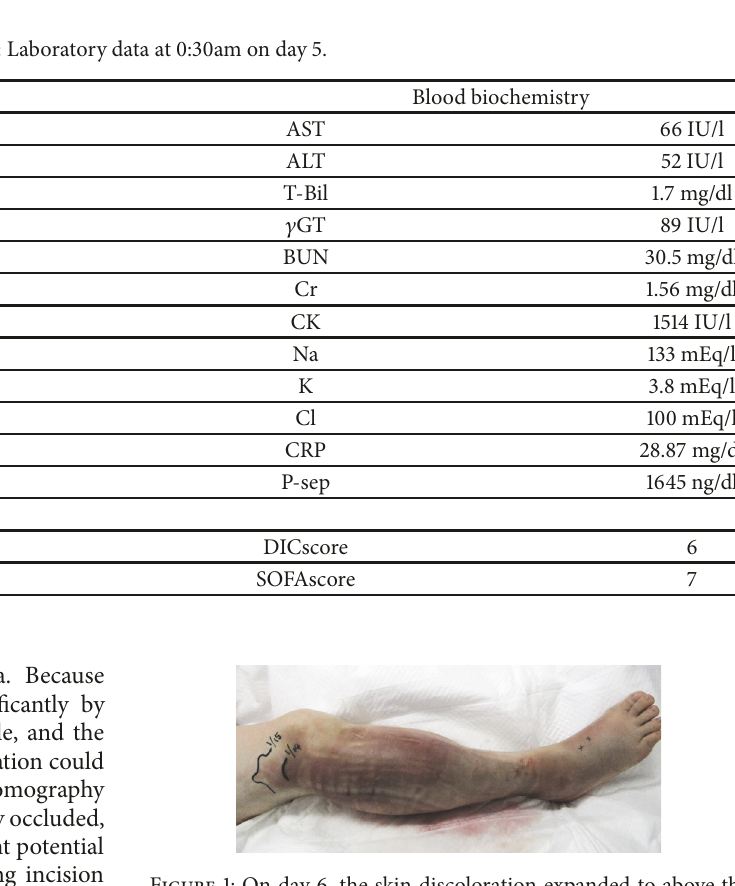
Figure 1: On day 6, the skin discoloration expanded to above the right